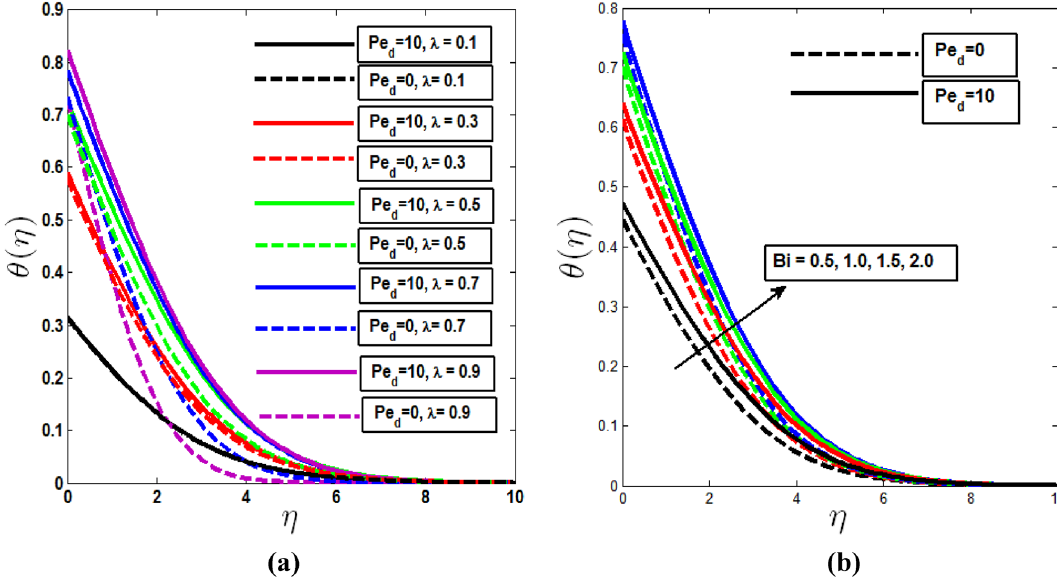
Figure 3. Temperature profile with the ( a ) variation of mixed convection parameter, ( b ) Biot number in the presence and absence of thermal dispersion